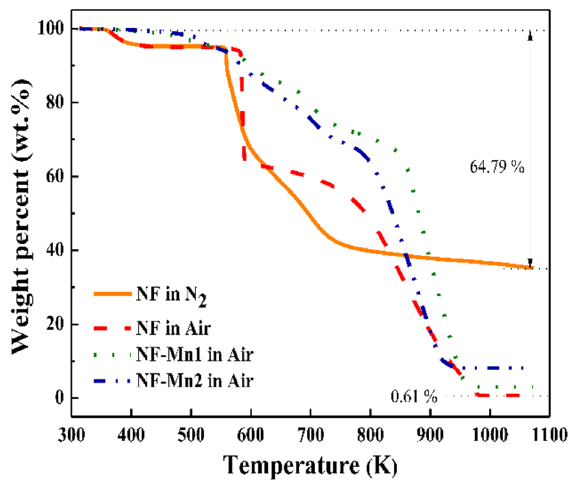
Figure 2. Thermogravimetric analysis (TGA) curves of electrospun PAN‐based nanofiber and manganese acetate embedded‐PAN‐based nanofibers.